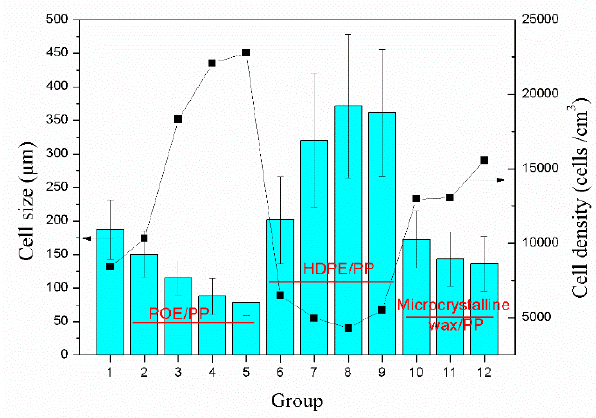
Figure 5. Cell size and cell density of the foaming samples with di ff erent polymer blends.